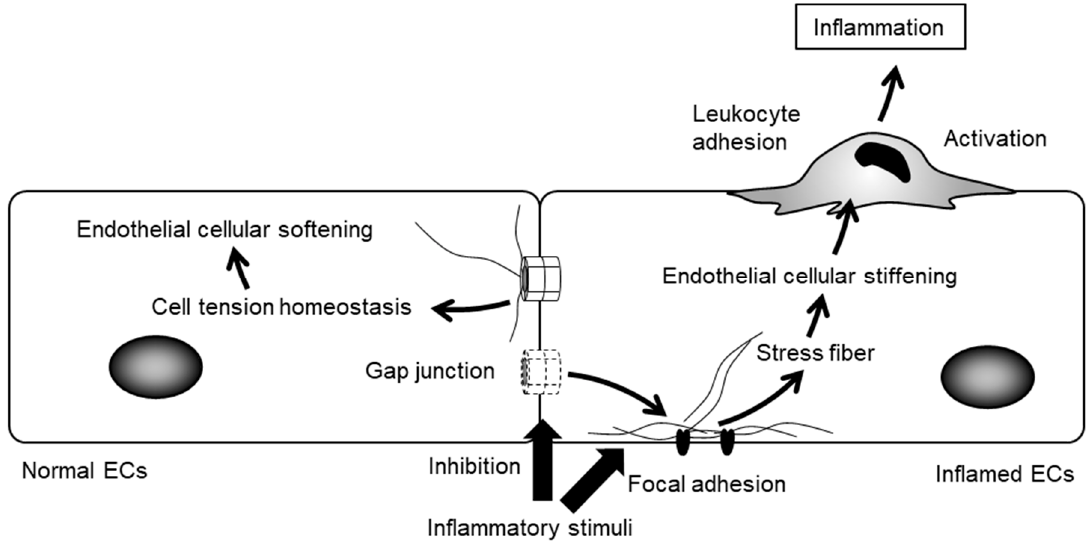
Figure 6. Endothelial GJs modulate cellular stiffness in response to inflammatory stimuli. ECs induce the formation of focal adhesion and stress upon inflammation. Inhibition of endothelial GJs strengthens them, leading to increased cellular stiffness. Leukocytes modulate cell adhesion, spreading and migration, depending on the degree of endothelial cellular stiffness.